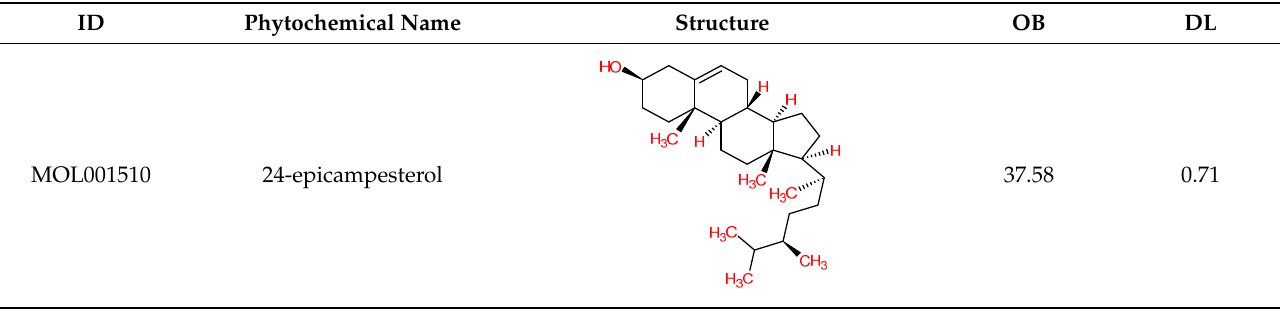
Table 1. Active phytochemicals in Cnidium monnieri .